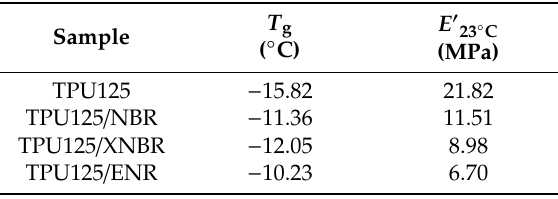
Figure 9. Thermomechanical curves of the TPU matrix and the TDVs. Table 2. The glass transition temperatures ( T g ) and room temperature storage modulus ( E ′ 23 °C ) of the TDVs.